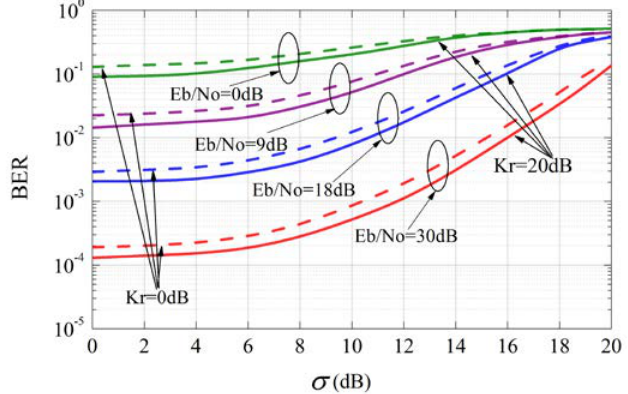
Figure 7. Relationship between BER and shadowing standard deviation.